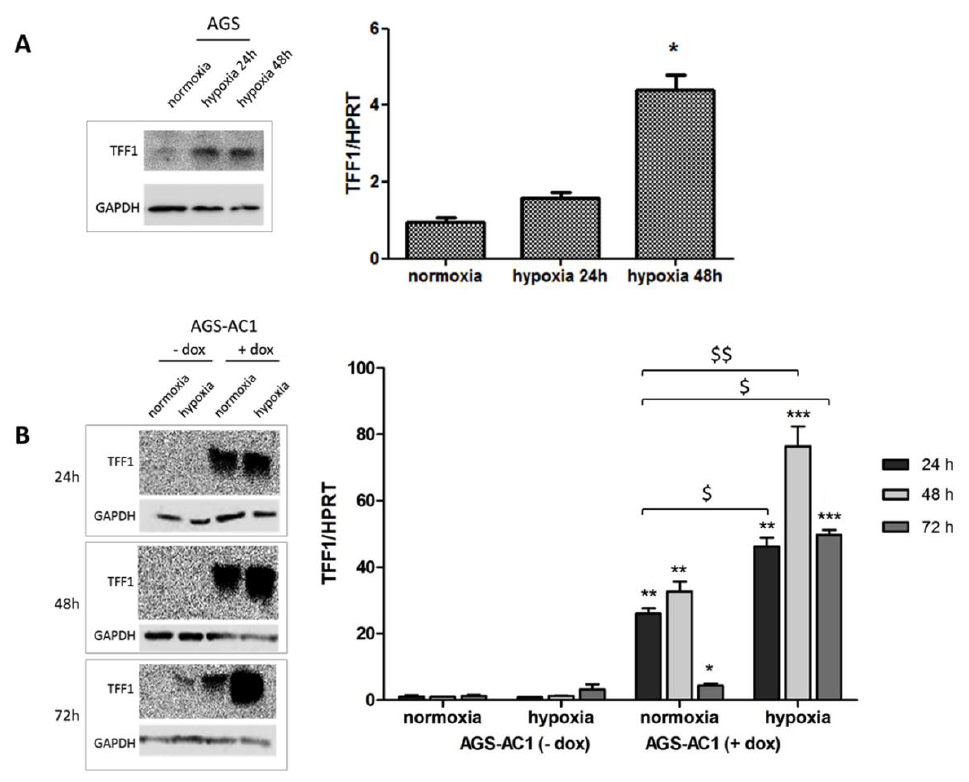
Figure 5. Hypoxia-induced TFF1 expression in cellular models. Expression of TFF1 in AGS cells after 24 and 48 h of hypoxia ( A ) and in AGS-AC1 cells after 24–48–72 h of hypoxia ( B ). Left panel, protein level of TFF1 detected by western blotting and normalized with corresponding GAPDH. Right panel, mRNA level of TFF1 by real-time PCR, measured on mRNA levels of HPRT in the same experimental models. * p < 0.05, ** p < 0.01 and *** p < 0.001 vs. AGS/AGS-AC1 cells in normoxia, $ p < 0.05 and $$ p < 0.01 vs. AGS-AC1 induced cells in normoxia.